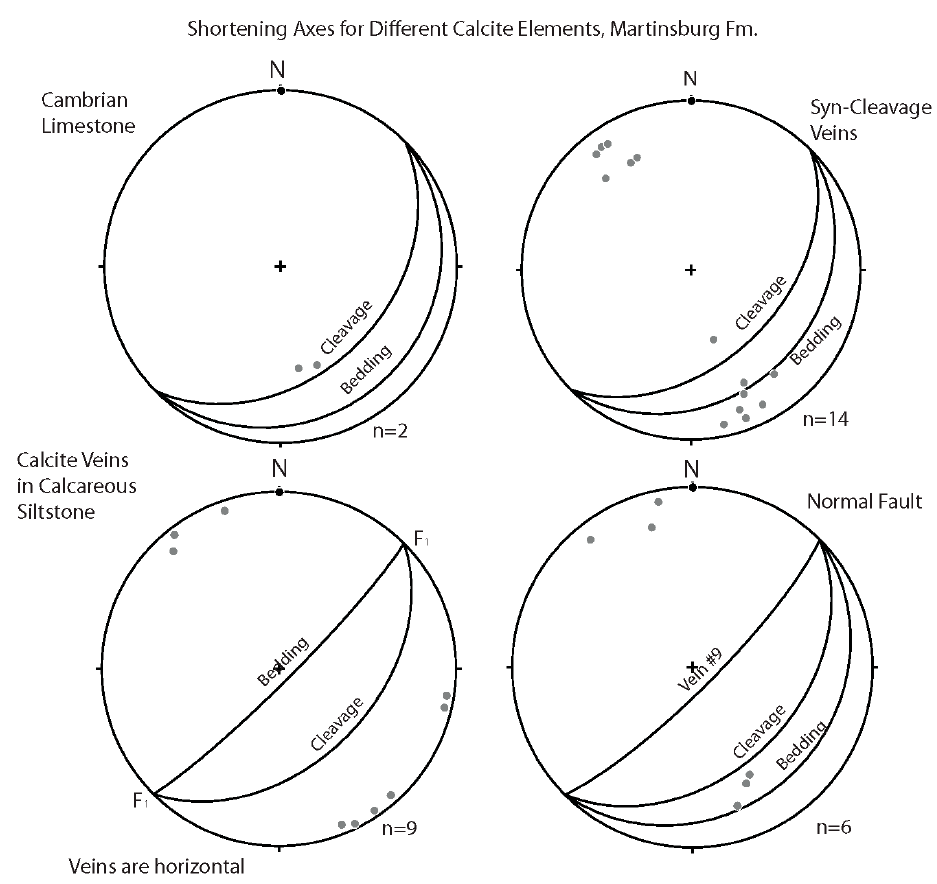
Figure 4. Lower hemisphere projections of calcite twin shortening axes for the various calcite phases, Delaware Water Gap, New Jersey. See Table 2 for details.